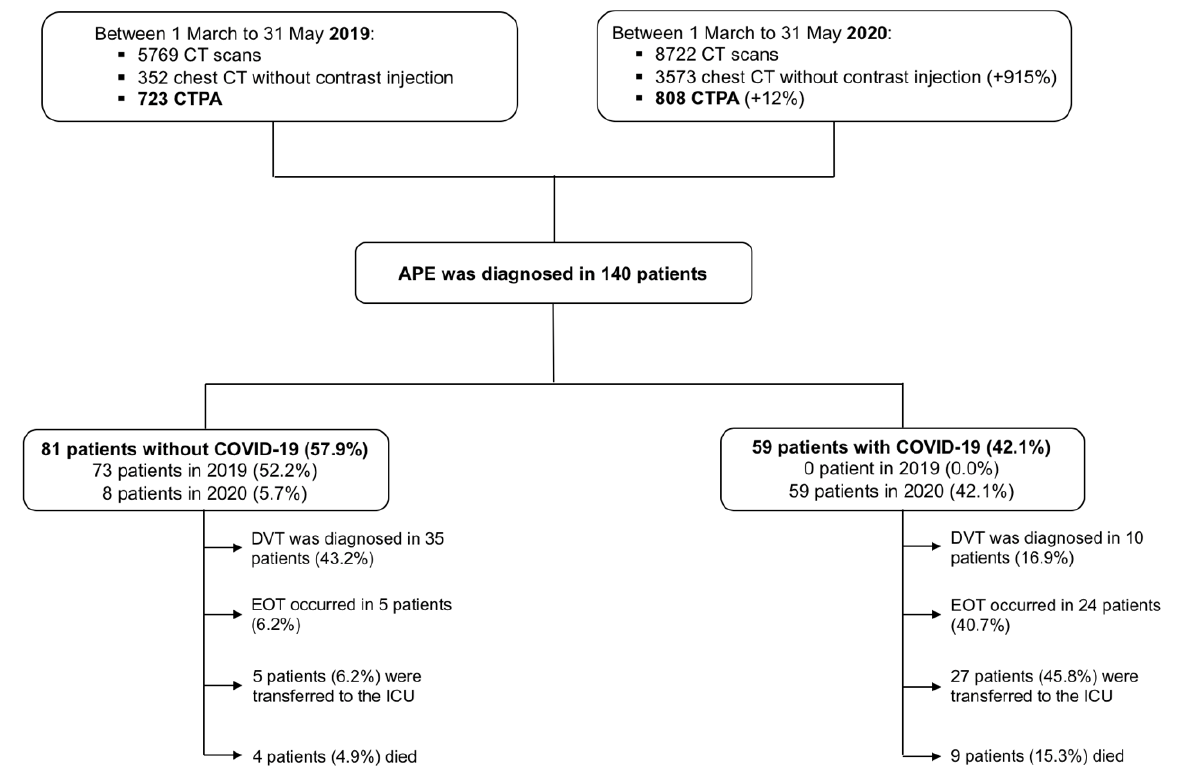
Figure 1. Flow-chart of the study.